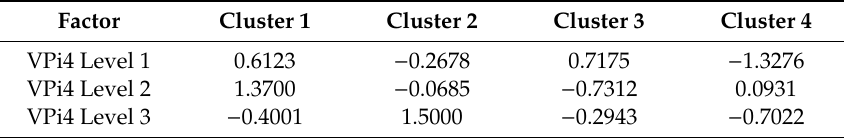
Table 4. Results of k-means clustering—cluster means (centroids).